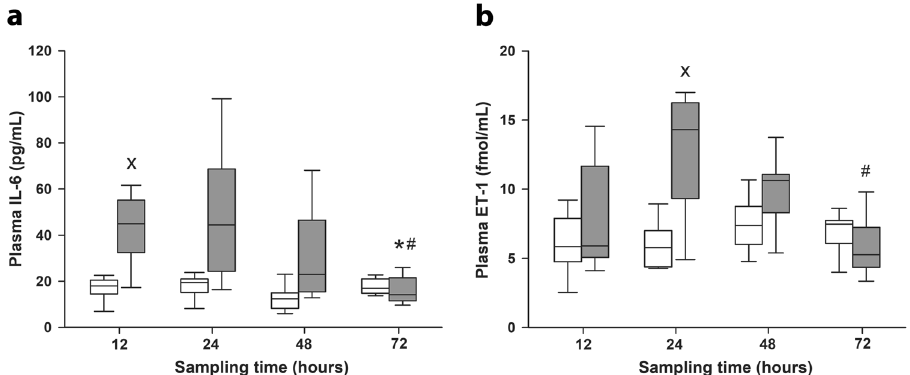
Figure 2. Plasma interleukin 6 (IL-6) (a) and endothelin-1 (ET-1) concentrations (b) in sham-operated animals (n = 12–13, white boxes) and in the different sepsis groups representing different stages of sepsis (grey boxes). The number of animals used in the various sepsis groups is indicated in Table 1. Plots demonstrate the median (horizontal line in the box) and the 25th (lower whisker) and 75th (upper whisker) percentiles. A comparison between groups was conducted with the Kruskal–Wallis test followed by Dunn’s post-hoc test. X P < 0.05 vs sham-operated groups; * P < 0.05 vs 12 h sepsis (between sepsis groups); # P < 0.05 vs 24 h sepsis (between sepsis groups).